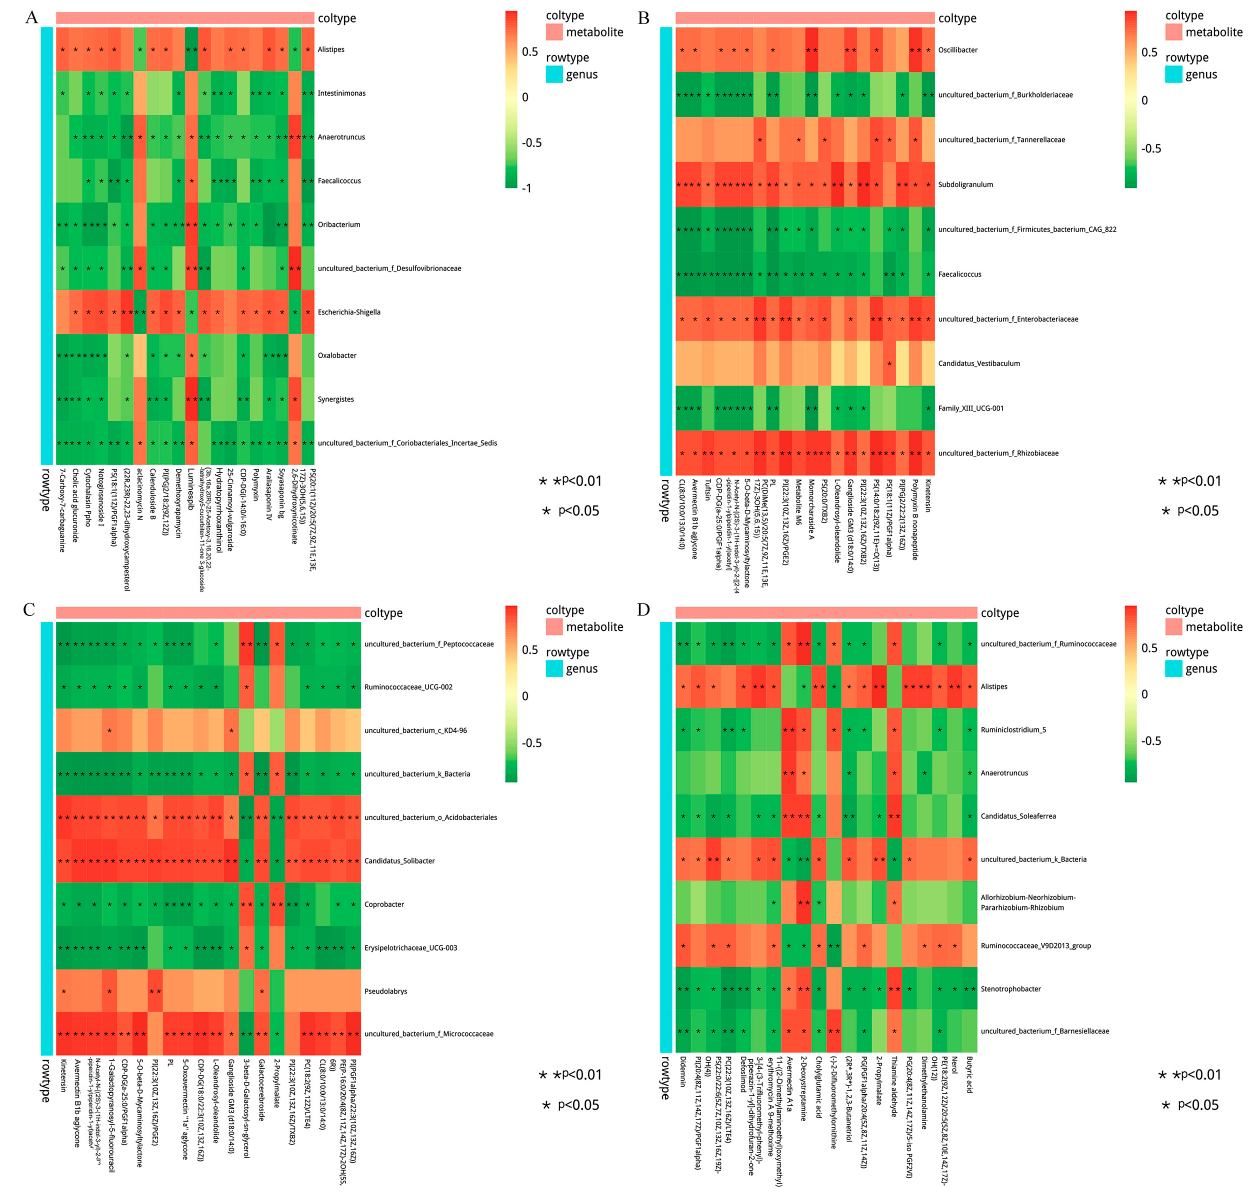
Figure 6. Heatmap of the correlation between differential cecal microbes and metabolites. The different colors represent the magnitude of spearman’s correlation coefficient. Red color indicates positive correlation, while green color indicates negative correlation. * p < 0.05, ** p < 0.01, *** p < 0.001. Heat map of top 20 differential genus and top 20 differential metabolite correlations: ( A ) d27 vs. d53, ( B ) d53 vs. d105, ( C ) d105 vs. d133, ( D ) d133 vs. d161. d027, n = 5; d053, n = 5; d0105, n = 5; d133, n = 5; d161, n = 5.